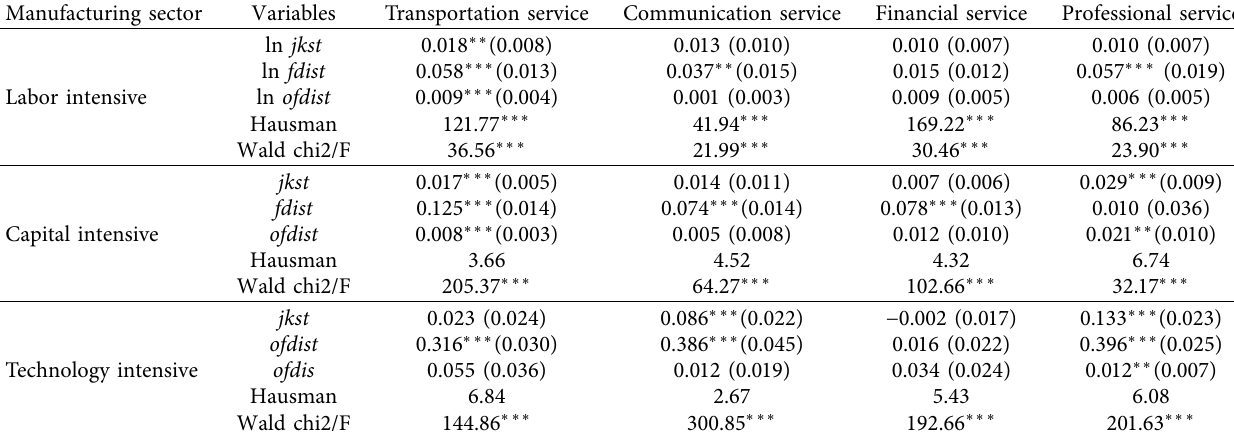
Table 6: Estimated results of producer service sector openness and manufacturing sector.